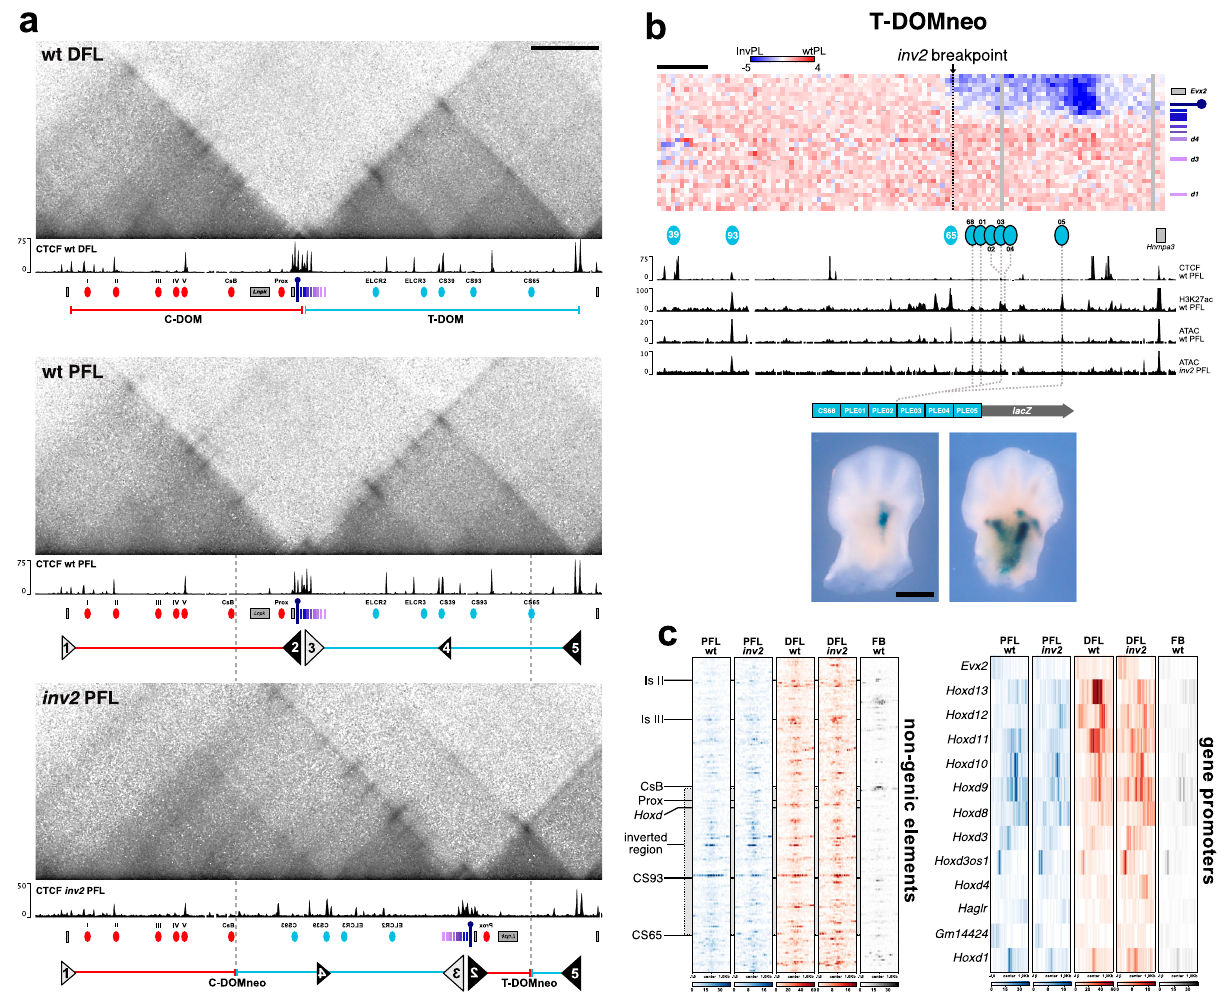
Fig. 2 Hoxd13 establishes new contacts with proximal limb enhancers in the inv2 allele. a Capture Hi-C using E12.5 wild type distal (top, DFL) and proximal (center, PFL) limb cells, as well as mutant inv2 proximal limb cells (bottom, PFL). Bin size is 5 kb, color scale is log transformed. Wild type samples are mapped to wild type chr2 and inv2 is mapped on a reconstructed mutant chromosome 2 (mm10). Below each heatmap are CTCF CUT&RUN tracks produced from the indicated tissues and the black and white triangles indicate the orientations of large (large triangles) or small (small triangles) groups of occupied CTCF sites. The gray dashed lines between the wild type PFL and inv2 PFL indicate the breakpoints of the inversion. In the inv2 allele, the observed changes in chromatin contacts matches the expectations based on groups of CTCF sites with convergent orientations. The groups are labeled from 1 to 5 to facilitate the reading of the pro fi le after inversion. Hoxd genes are colored in shades of magenta and the position of Hoxd13 is indicated with a purple pin. b The top panel shows the subtraction between the CHi-C contacts established by Hoxd13 and proximal limb enhancers in wild type and in inv2 proximal limb cells (each bin is 5 kb). Blue bins represent contacts more frequently observed in the inv2 proximal limb cells and are concentrated in the T-DOMneo domain, starting right after the position of the breakpoint (vertical line). The mapping is shown on the wild type chromosome for clarity (chr2: 75129600 – 75677400). Scale bar is 55 kb. The tracks below show CTCF CUT&RUN, H3K27Ac ChIP 19 , and ATAC using E12.5 wild type or inv2 proximal forelimb cells, mapped onto wild type mm10. Previously characterized proximal limb enhancers are indicated by blue ovals below the heatmap. Putative proximal limb enhancers that gain contact with Hoxd13 in the inv2 allele are indicated by blue ovals with a black border. These elements (CS68 and PLE01 to 05) were identi fi ed through the H3K27Ac and ATAC pro fi les in wild type and inv2 proximal forelimbs and were cloned into a single lacZ reporter transgenic construct. Representative staining patterns in forelimb buds are shown below (see Supplementary Fig. 2e). All embryos that stained (7 of 7) produced a variation of the proximal limb staining. Scale bar is 0.5 mm. c Comparison of ATAC-seq datasets between the pro fi les in control and inv2 proximal forelimbs. The heatmaps on the left are peaks from ATAC samples mapped onto non-genic elements at the HoxD locus, illustrating the high similarity between samples of the same tissue, regardless of genotype. The regions corresponding to the gene bodies of Lnpk , Mtx2 , and the region from Evx2 to Hoxd1 have been removed. The heatmaps on the right are the ATAC pro fi les over accessible gene promoters in the HoxD cluster. The PFL samples are generally similar while the DFL samples show more difference, in particular on Hoxd13 and Hoxd11 promoters. With the exception of the PLE lacZ transgenic embryos, all experiments were performed on embryonic samples homozygous for the indicated